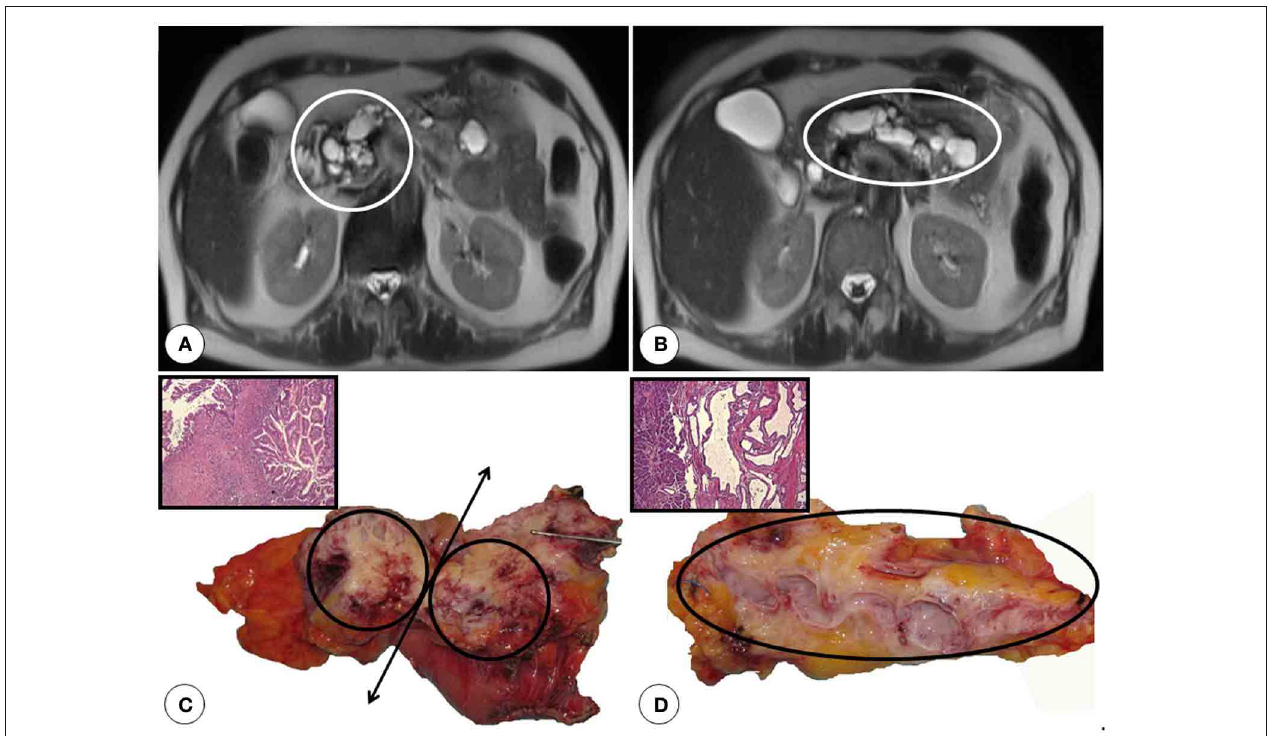
Eosin staining of an area showing invasive cancer with abundant stroma is shown as inset. The circles mark the desmoplastic pancreatic head tumor. (D) The resected pancreatic body/tail is cut open longitudinally in the middle. Notice the cystic dilatation of the pancreatic duct and the atrophic and fatty pancreas. Hematoxylin and Eosin staining of a region with high grade intraepithelial neoplasia is shown as inset, original magnification